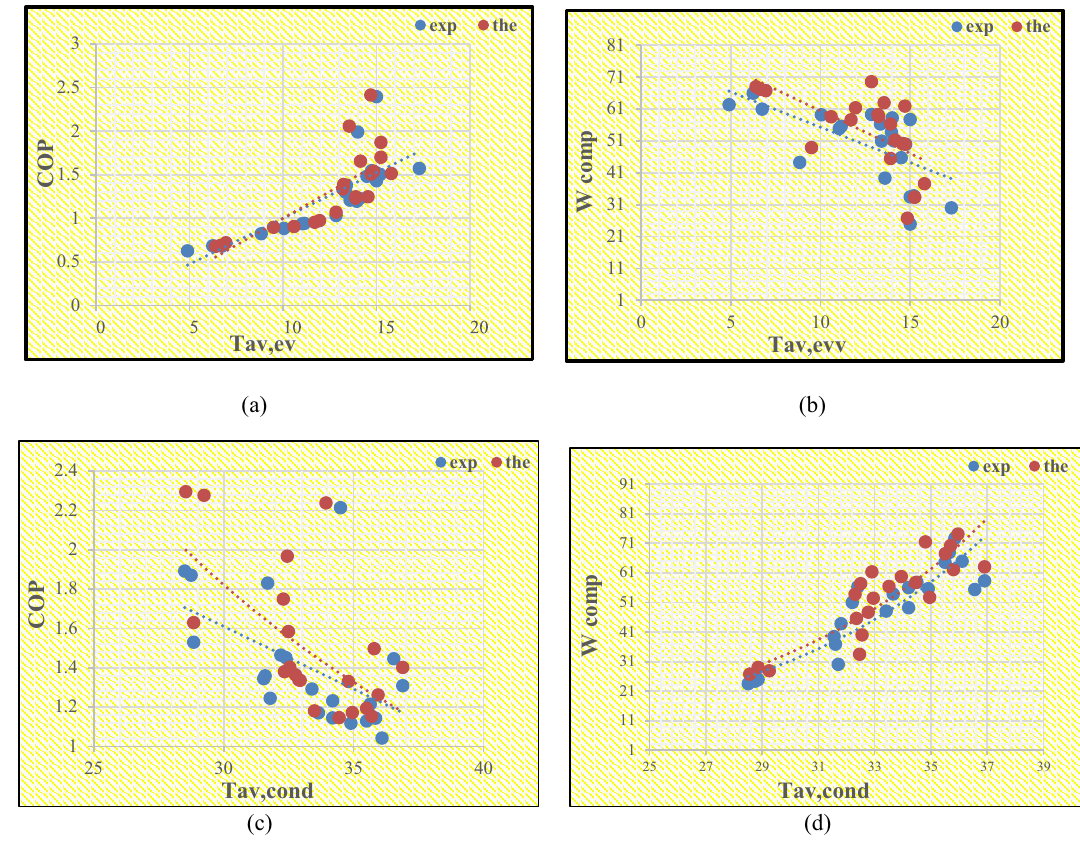
Figure 5. ( a ) The effect of Tav, ev on Cop, ( b ) The effect of Tav, ev on the power consumption, ( c ) The effect of Tav, cond on COP and ( d ) The effect of Tav, cond on the power